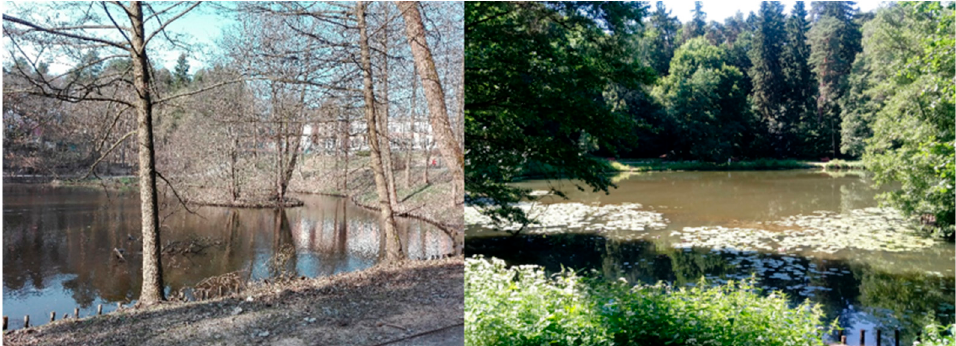
Figure 2. Vegetation in the Jakubowo park in two periods. Leafless (April 2018) and leafy period (May 2018).